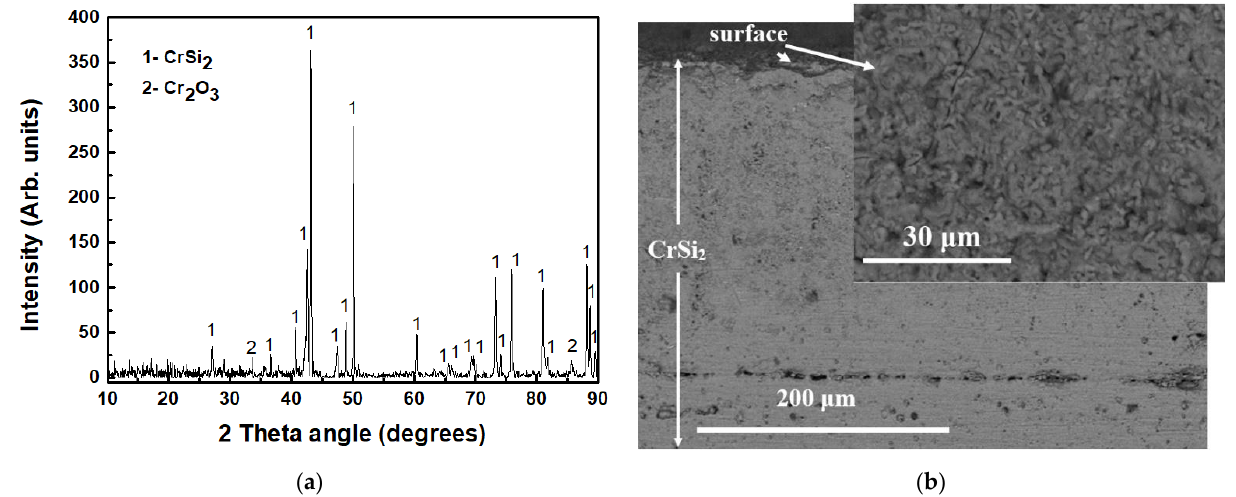
Figure 12. ( a ) Bragg – Brentano XRD pattern; ( b ) SEM micrographs of non-isothermally oxidized CrSi 2 samples during non-isothermal oxidation from ambient temperature to 1000 °C. The peaks were indexed by the use of PDF #35-0781 (CrSi 2 ) and #38-1479 (Cr 2 O 3 ) [34].